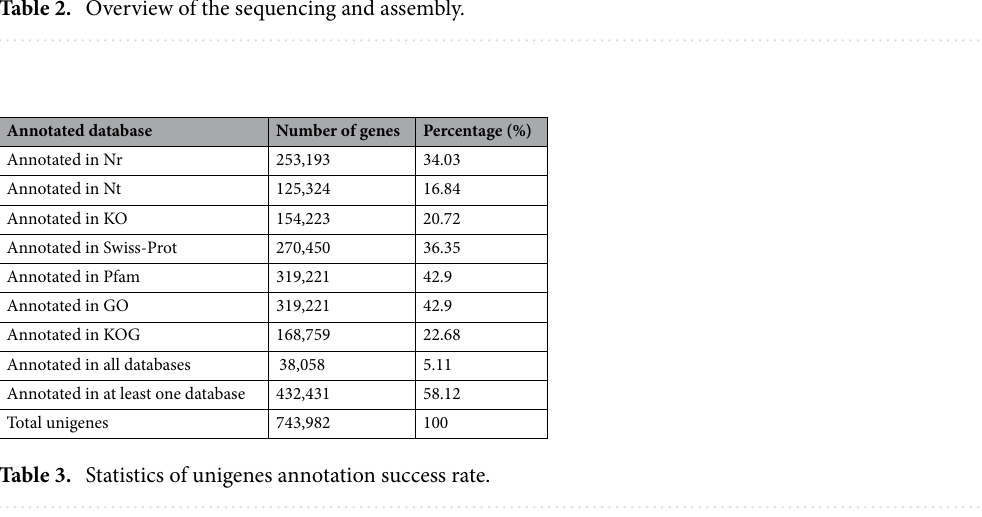
Table 2. Overview of the sequencing and assembly.